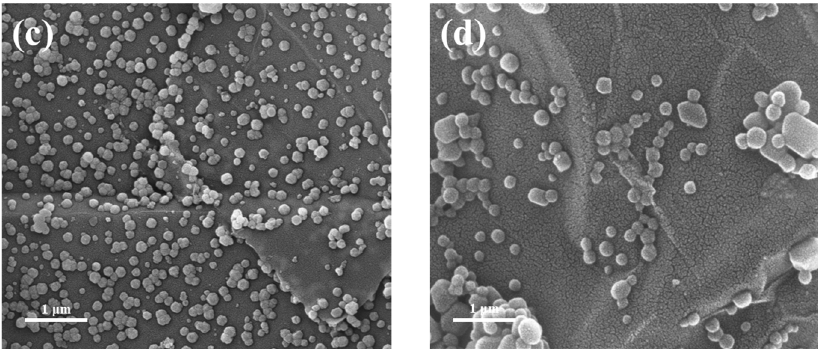
Figure 6. SEM of ( a ) GO and ( b ) UiO-66-NH 2 /GO 2% and ( c ) UiO-66-NH 2 /GO 5% and ( d ) UiO-66-NH 2 /GO 10%.